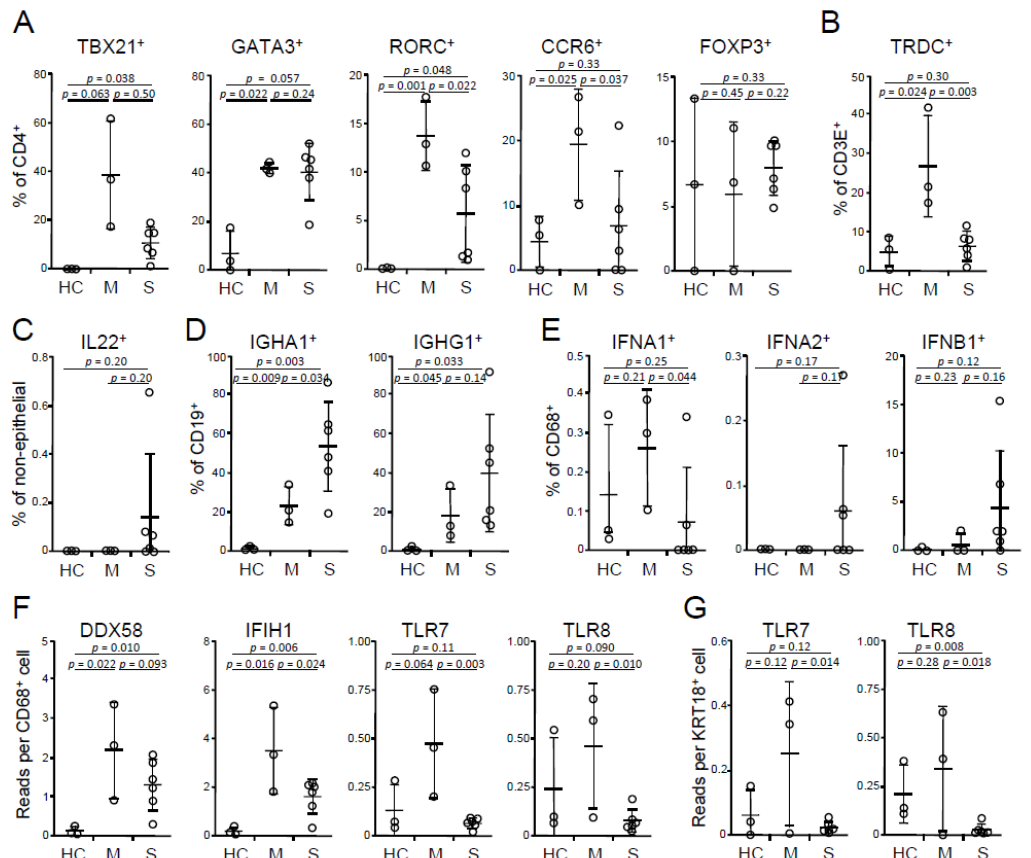
Figure 1. Dysregulation of TH and B cell profiles and IFN-I pathway in BALFs. ( A ) Frequencies of TH1 (TBX21 + ), TH2 (GATA3 + ), TH17 (RORC + or CCR6 + ) cells and regulatory T cells (FOXP3 + ) in BALF cells on a CD4 + CD14 − gate. ( B ) Frequencies of γδ T cells (TRDC + ) on a CD3E + gate. ( C ) Frequencies of IL22 + cells on a KRT18 − gate. ( D ) Frequencies of IgA1 (IGHA1)- and IgG1 (IGHG1)-expressing B cells on a CD19 + gate. ( E ) Frequencies of IFN-I-expressing macrophages on a CD68 + gate. ( F , G ) Abundances of RNA recognition receptors in ( F ) macrophages and ( G ) epithelial cells. HC, healthy control ( n = 3); M, mild ( n = 3); S, severe ( n = 6). Mean and s.d. are shown; p values; unpaired t -test.